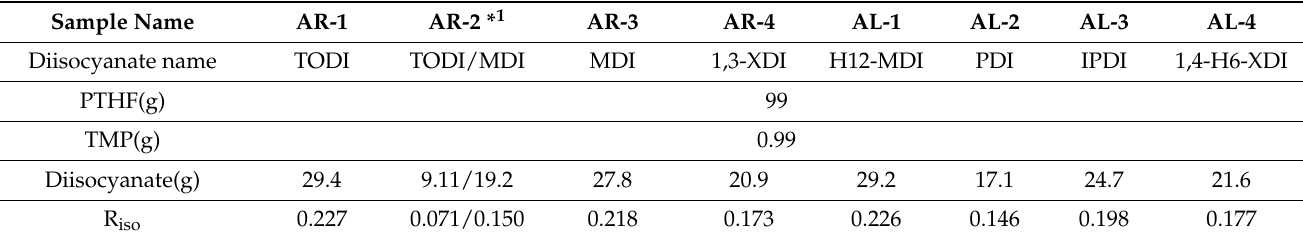
Table 2. Raw material composition of produced